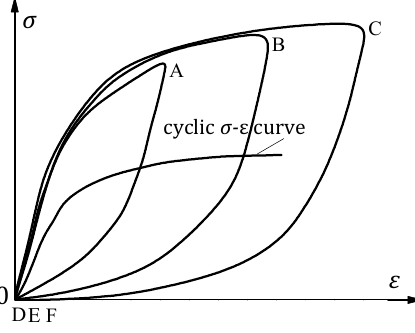
Figure 13. Masing behavior.